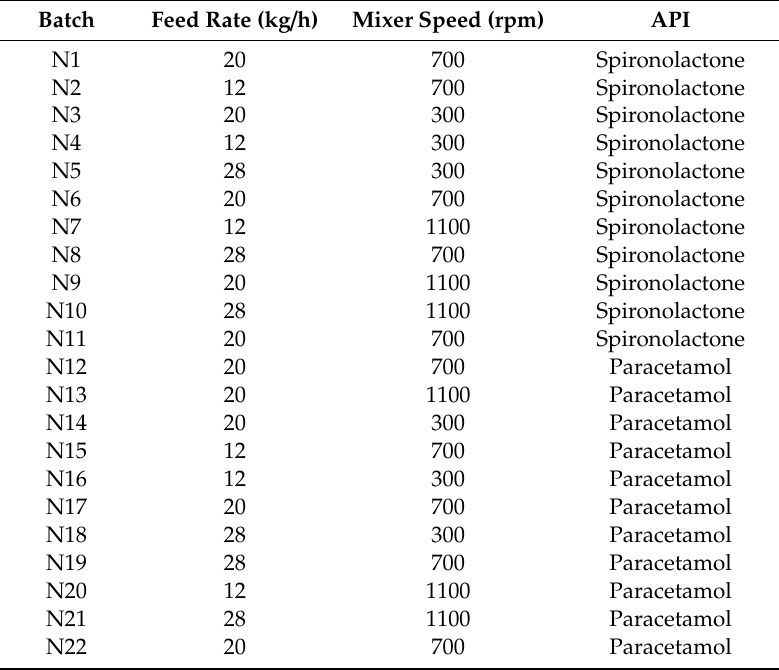
Table 1. Design of Experiments for the